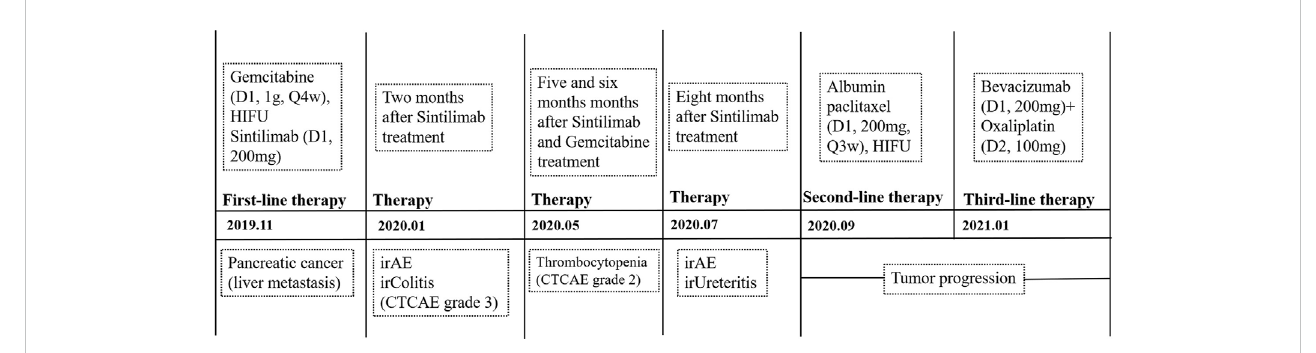
FIGURE 1 Schematic timeline of PD-1 treatment and its immune-related adverse